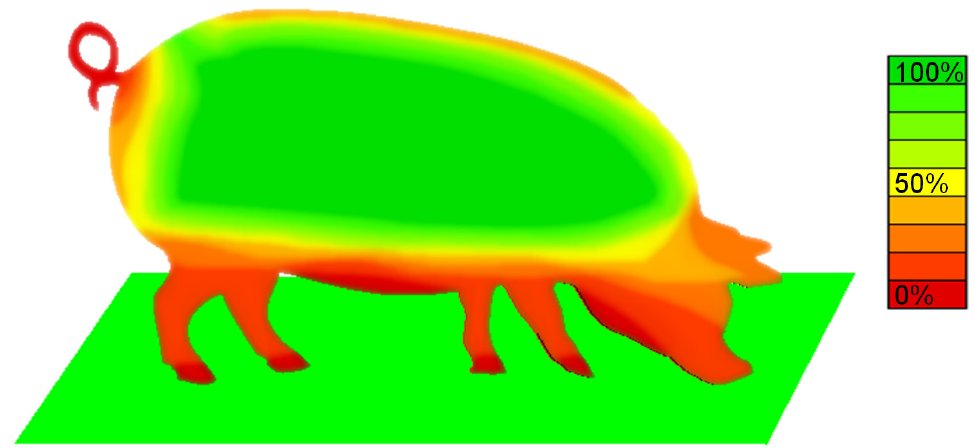
Figure 8. Percentage of 3D SfM processes which converged to an acceptable number of points, suitable for surface characterization.